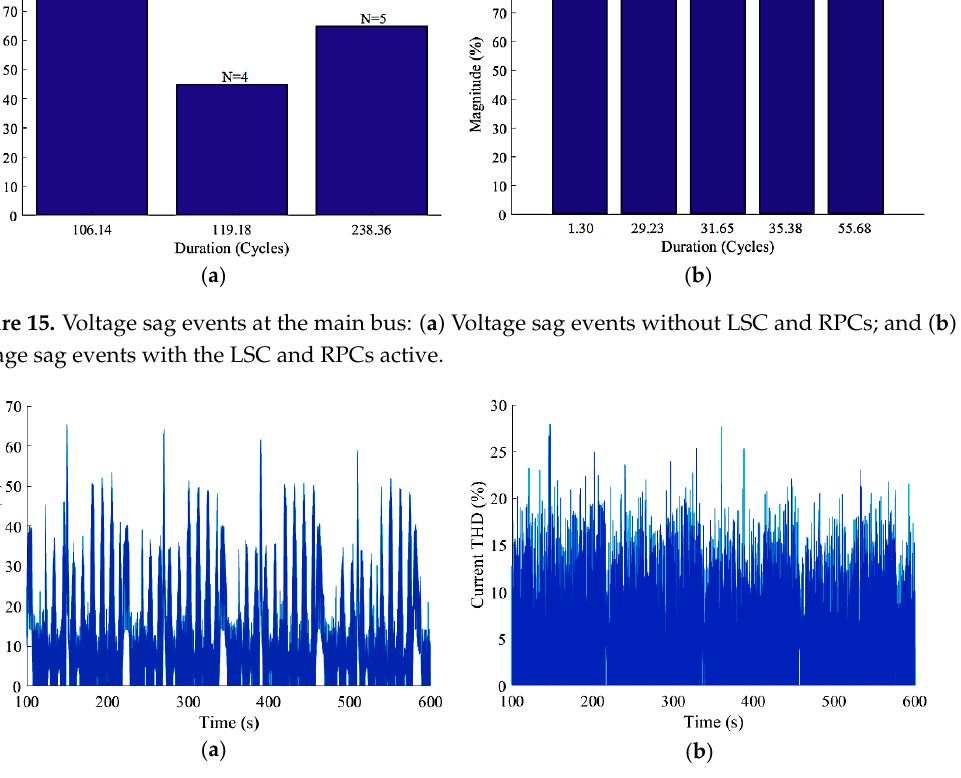
Figure 16. Current THD at the main bus: ( a ) Current THD without LSC and RPCs; and ( b ) current THD with LSC and RPCs active.